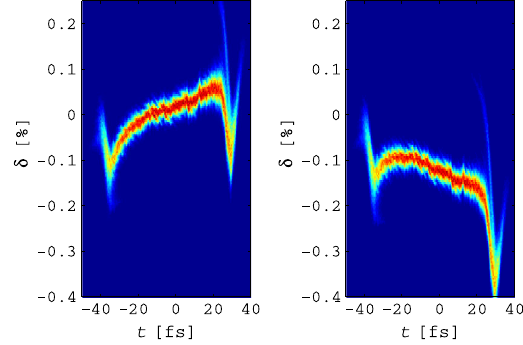
FIG. 9. Longitudinal phase space w = o (left) and w = (right) the dechirper wakefields after the dechirper location with half-gap 2 a ¼ 1 . 4 mm. Bunch head lies at the